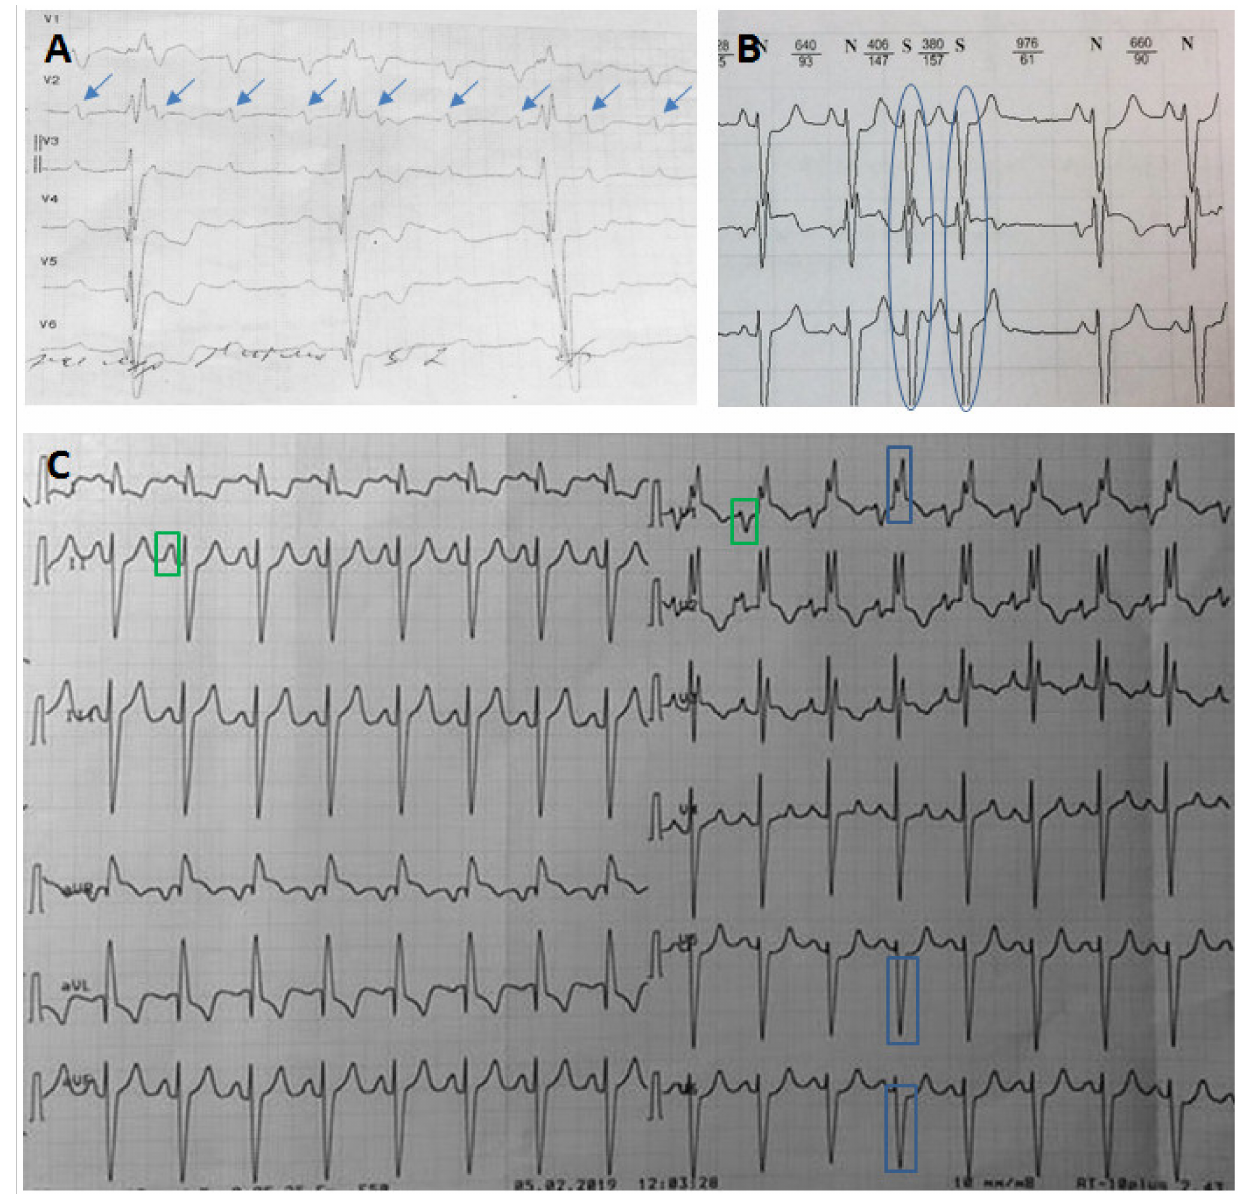
Figure 1. Electrocardiograms (ECGs) of the patient. ( A ) ECG fragment with complete AV block (p-waves are indicated by blue arrows). ( B ) A fragment of Holter ECG monitoring with frequent premature supraventricular beats (premature complexes are indicated by blue ovals). ( C ) ECG of the patient on admission. Sinus tachycardia (100 beats per minute), right bundle branch block (indicated by blue rectangles) combined with left anterior fascicular block (left axis deviation). Signs of enlargement of both atria (indicated by green